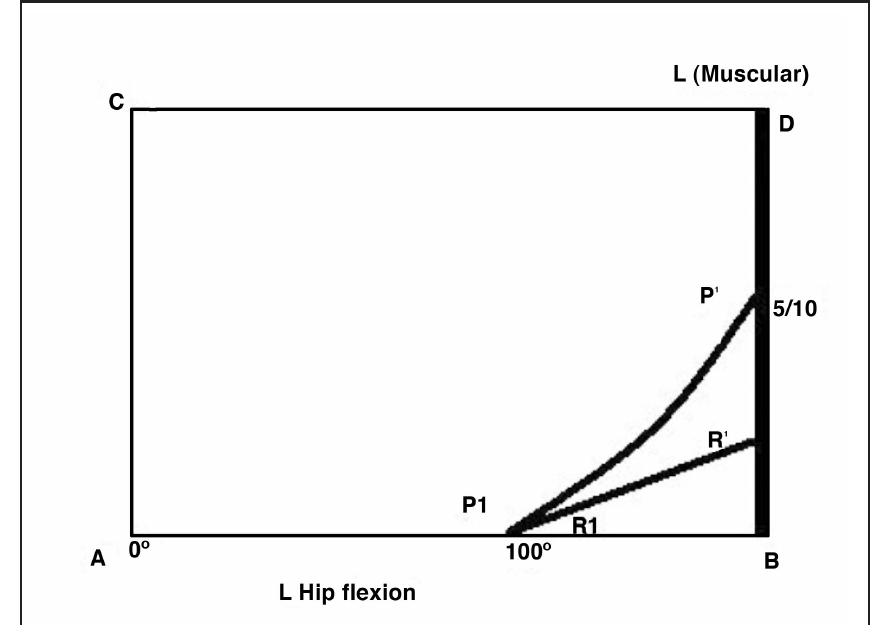
Figure 2: Movement